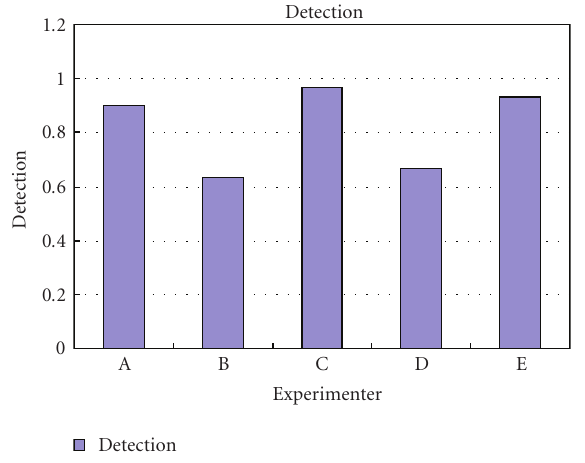
Figure 9: Detection of five